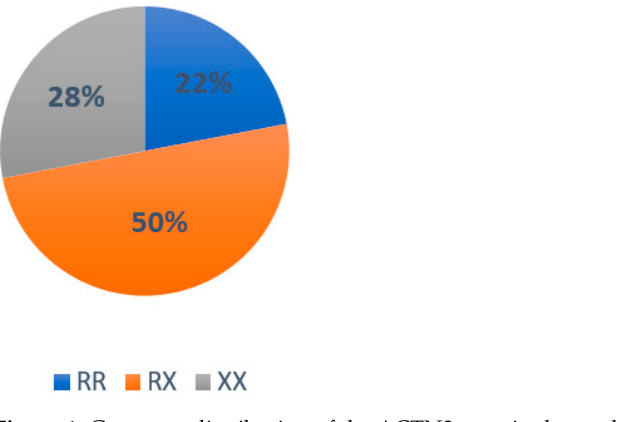
Figure 1. Genotype distribution of the ACTN3 gene in the study population.